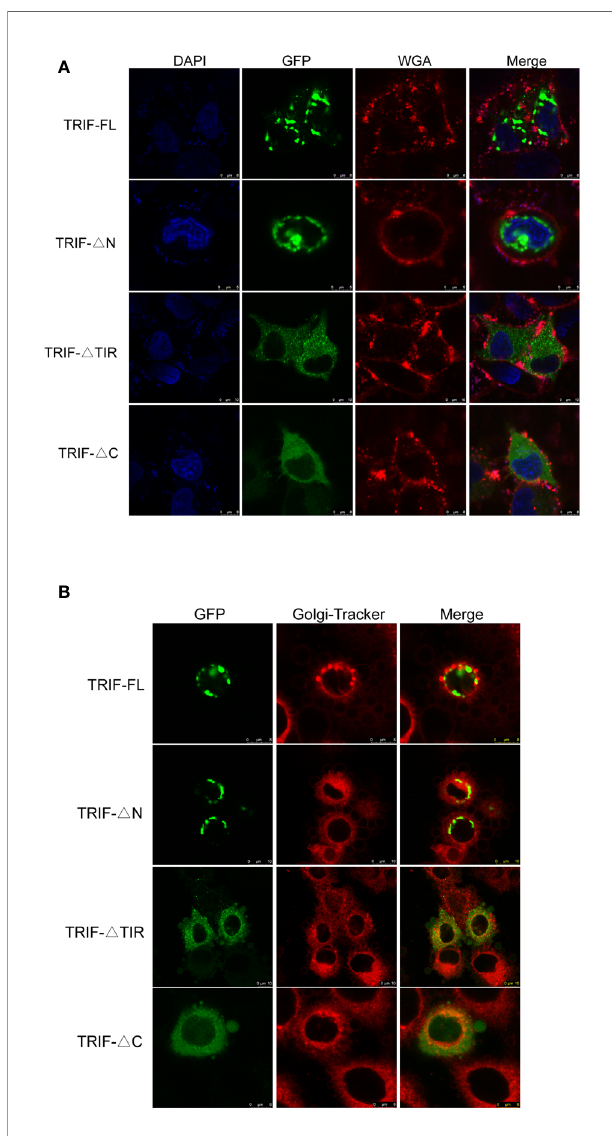
FIGURE 3 | Localization of full-length and truncated forms of carp TRIF. (A) Different mutants of carp TRIF, including TRIF-EGFP, TRIF- △ N-EGFP, TRIF- △ TIR-EGFP, or TRIF- △ C-EGFP, were transfected into HeLa cells. At 24 h post-transfection, the cells were stained with WGA (cell membrane marker) and DAPI, then visualized by confocal laser microscopy. Red, green, and blue represented the cell membrane, carp TRIF, and nucleus, respectively. (B) HeLa cells were transfected with different mutants of carp TRIF, including TRIF-EGFP, TRIF- △ N-EGFP, TRIF- △ TIR-EGFP, or TRIF- △ C-EGFP. At 24 h post- transfection, the cells were stained with Golgi-Tracker Red and imaged using a laser scanning confocal microscope. Green indicated the TRIF protein. The Golgi complex was stained in